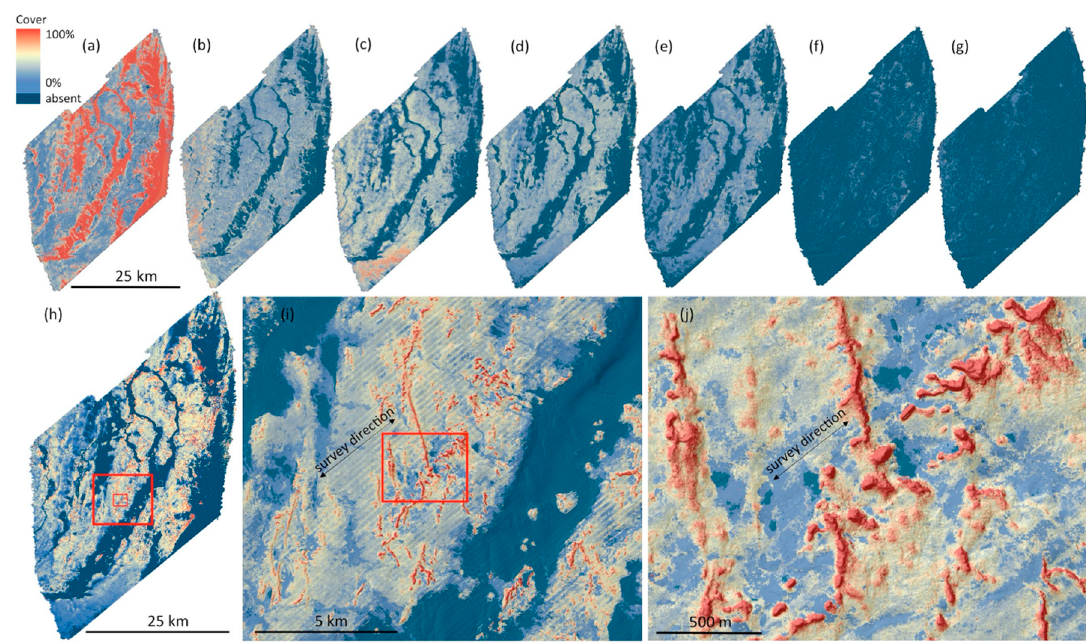
Figure 4. Coverage maps (%) of substrate components on Hoburgs Bank. ( a ) sand (0.006–0.2 cm), ( b ) gravel (0.2–2 cm), ( c ) pebbles (2–6 cm), ( d ) large stones (6–20 cm), ( e ) boulders (20–60 cm), ( f ) large boulders ( > 60 cm), ( g ) hard clay, ( h ) hard bottom, ( i ) hard bottom zoom 1 with hillshade, ( j ) hard bottom zoom 2 with hillshade. Absence is based on modeled threshold ( < 0.01% cover).